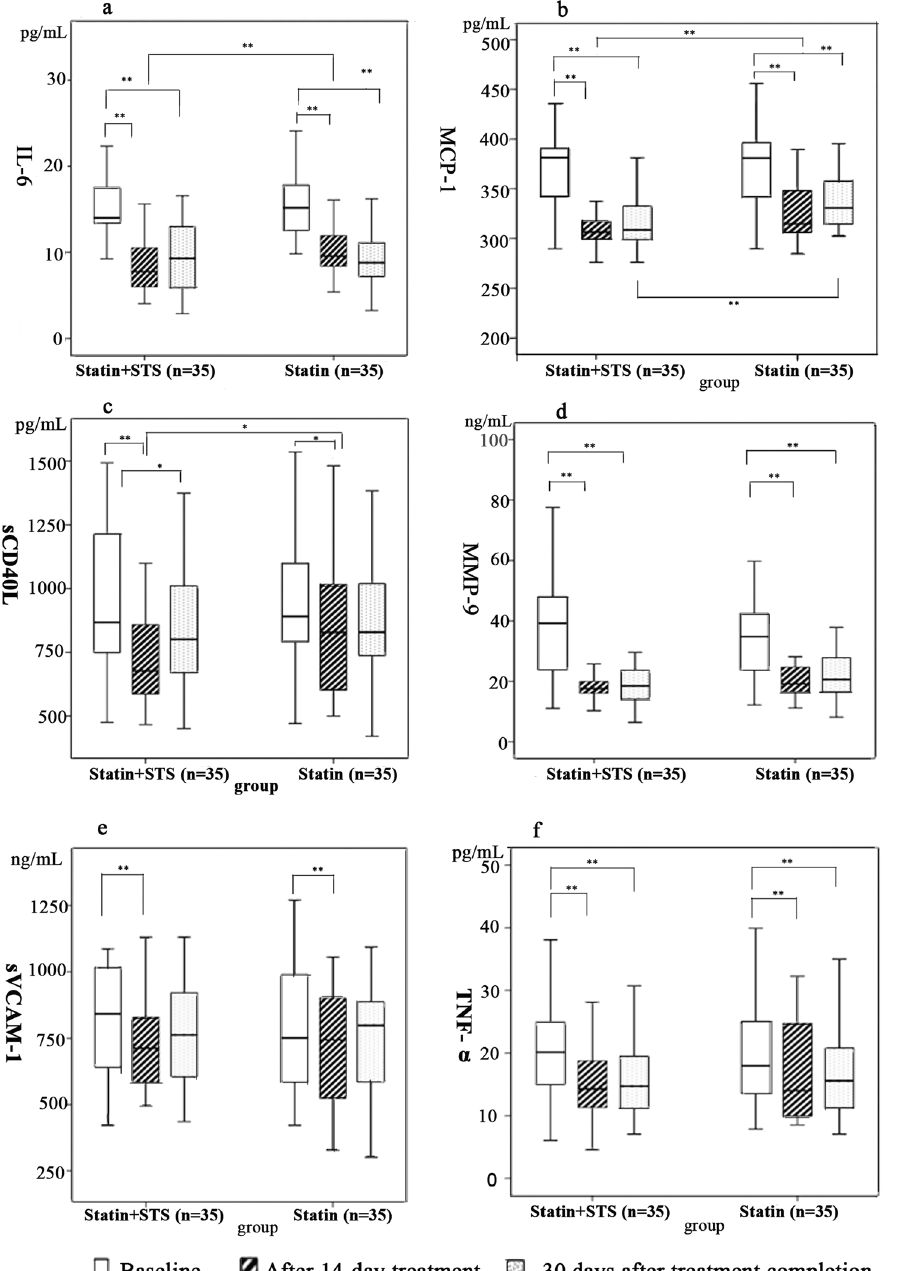
Figure 4. Comparison of IL-6, MCP-1, sCD40L, MMP-9, sVCAM-1, and TNF- 𝛼 levels between groups at baseline, after 14-day treatment, and at 30 days after completion of treatment. * Statistically significant, p < 0.05. ** Statistically significant, p < 0.01. IL-6, interleukin-6; MCP-1, monocyte chemotactic protein-1; MMP-9, matrix metalloproteinase-9; sCD40L, soluble CD40 ligand; sVCAM-1, soluble vascular cell adhesion molecule-1; STS, sodium tanshinone IIA sulfate; TNF- 𝛼 , tumor necrosis factor